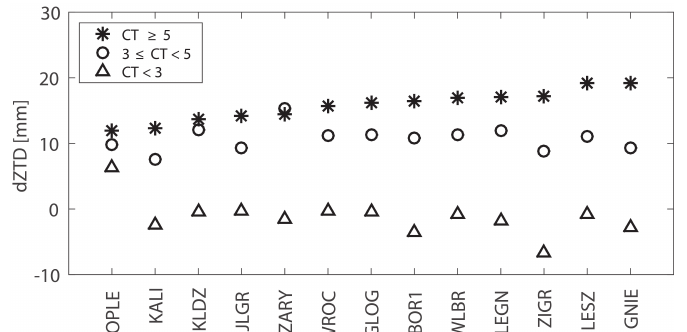
Figure 11. dZTD averaged in 56 days at 13 GNSS stations with respect to CT product. Stars represent highest concentration of cloud water (CT ≥ 5), circles show moderate cloud impact (3 ≤ CT < 5) whereas triangles refer to low cloud content (CT <